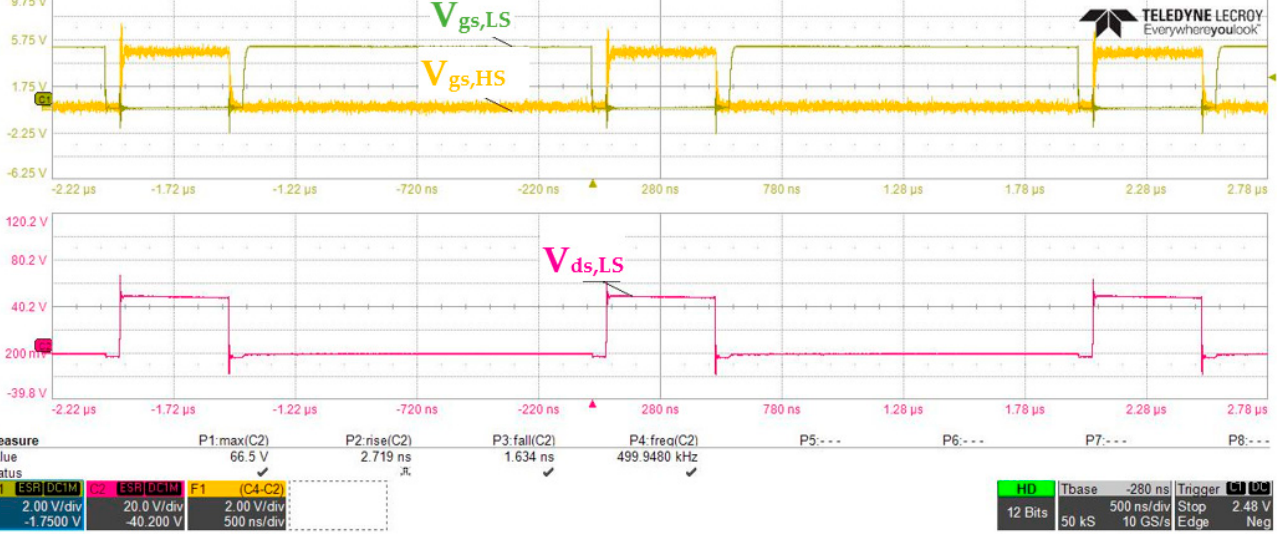
Figure 7. Efficiency at 500 kHz over current load. 3.2. Interleaved Synchronous Buck Converter Controlled with a Microcontroller The synchronous rectification technique is often used to improve the overall system efficiency. This solution replaces the diode with an active switch to avoid the conduction losses of the diode, thus reducing the power losses of the converter. In this context, the adopted buck converter with two active switches is implemented in a monolithic chip. Starting from the good results achieved with a single-phase converter, a three-phase in- terleaved structure has been chosen to maximize the overall system efficiency. This struc- ture provides better results in terms of efficiency compared to the previous one. With a three-phase system, it is possible to shift the peak efficiency of the single-phase converter to a higher current value. Figures 8 and 9 show the circuit schematic for a three-phase synchronous buck converter and the evaluation board.